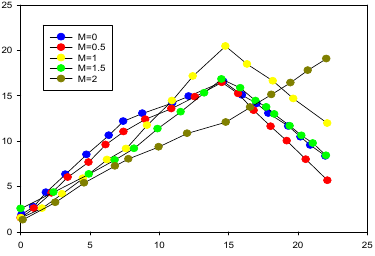
Figure 9. Image coding hidden threshold distribution selection.